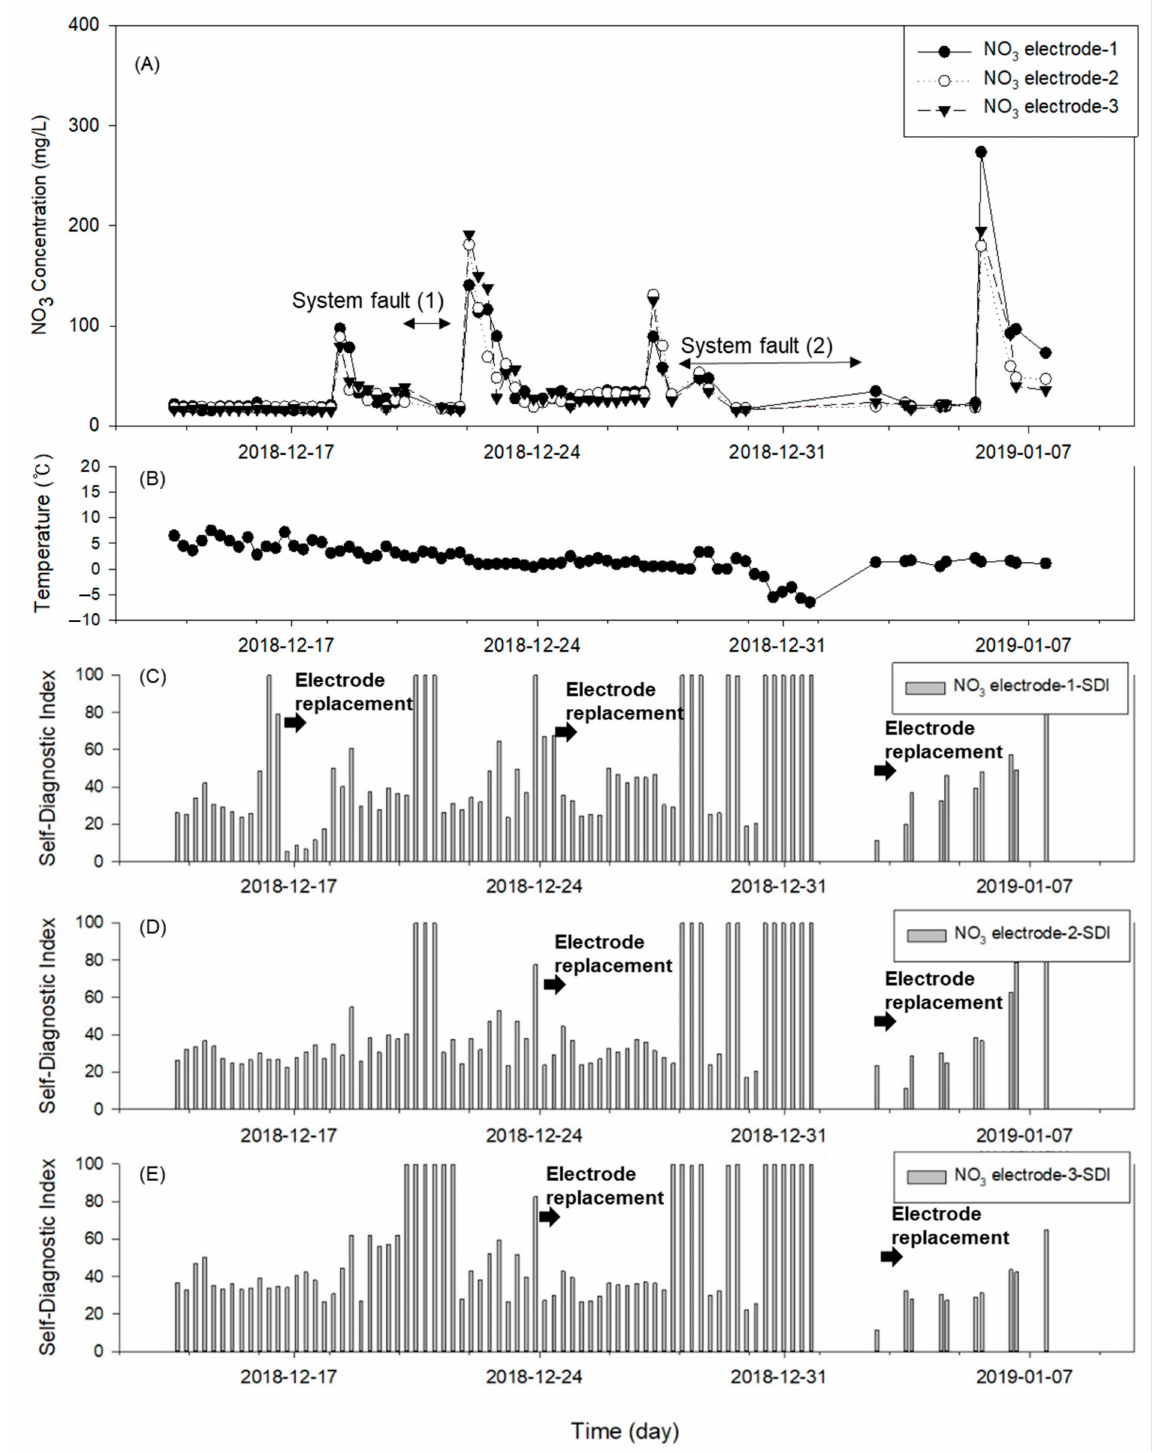
Figure 9. Field monitoring results: ( A ) NO 3 − concentration; ( B ) temperature variation; ( C – E ) variation in SDI and replacement histories of ( C ) electrode 1, ( D ) electrode 2, and ( E ) electrode